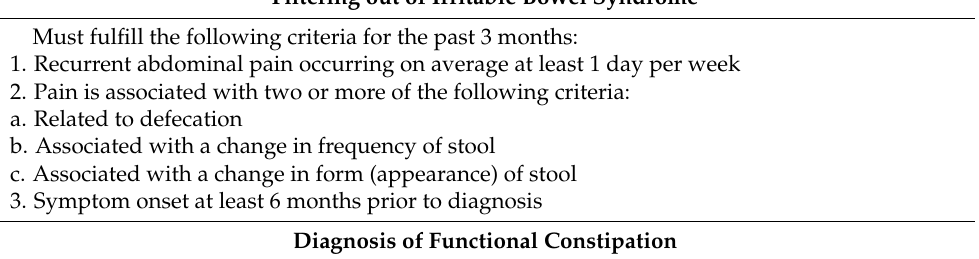
Table 1. Diagnosis of functional constipation. Filtering out of Irritable Bowel